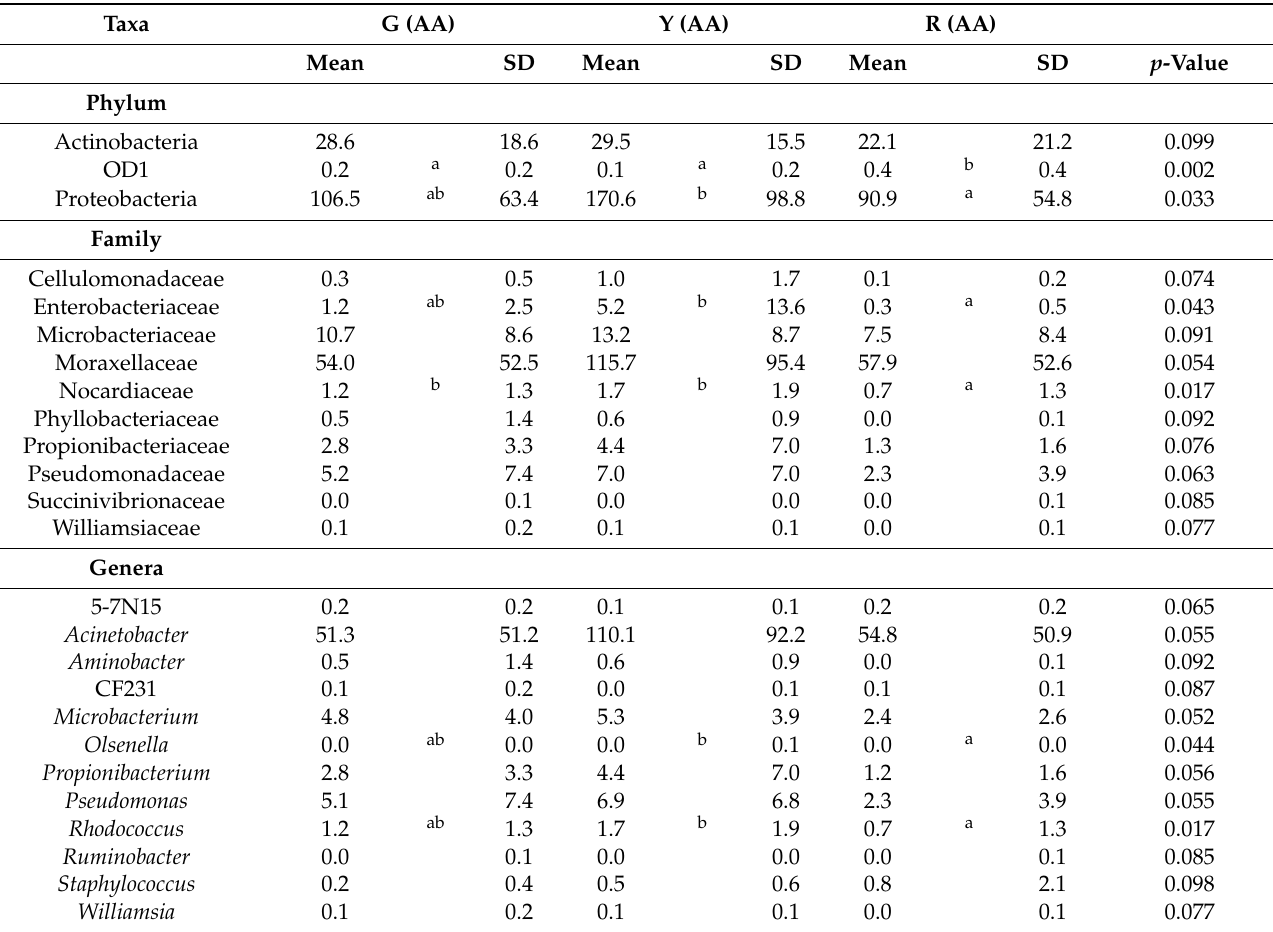
Table 4. Statistical comparison of the mean abundances of bacteria at a phylum, family and genus taxonomic levels measured in milk sampled from lactating cows classified as healthy (G), at risk (Y) and with subclinical mastitis (R) on the basis of total somatic cell count (SCC) and differential somatic cell count (DSCC). Only taxa which significantly differed with the Kruskal–Wallis non-parametric test are